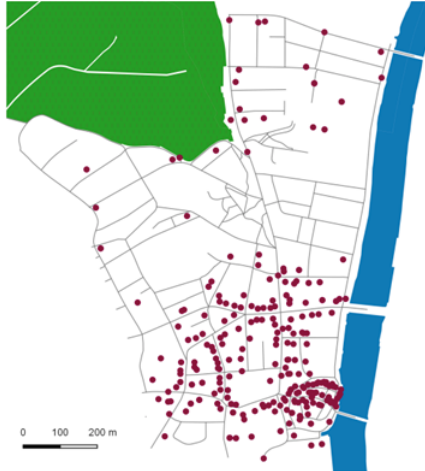
Figure 2. Study Perimeter with various amenities (red dots). (Data Sources: Amt für Geoinformation Kanton Solothurn 2016, OpenStreetMap Contributors 2016, Yellow Pages 3